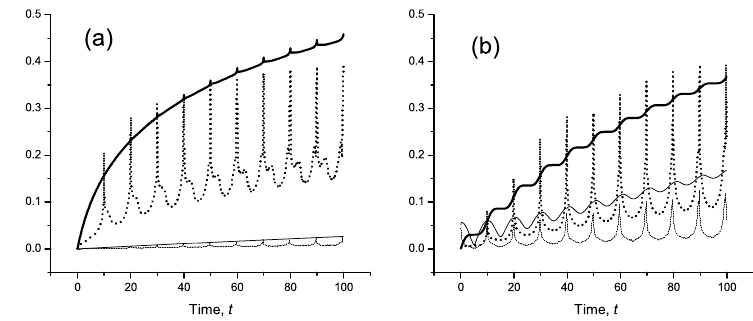
Figure 2. Comparison of solutions of (3.1) obtained by CFDS at (a) h =1/64 and τ 0 =0.0001, τ 1 =0.001, τ 2 =0.01, and (b) τ =0.001 and h 0 =1/128, h 1 =1/64, h 2 =1/32.